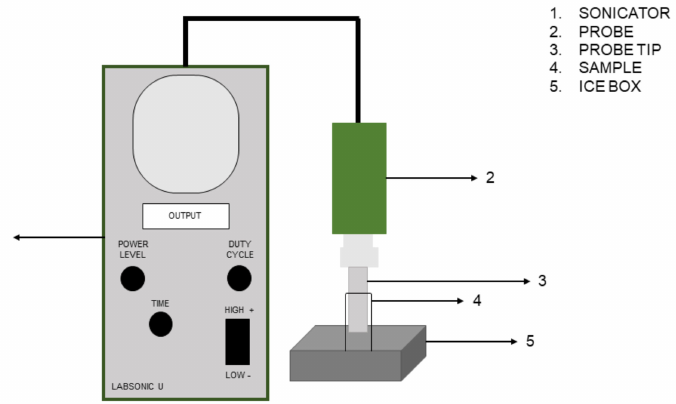
Figure 1. Schematic representation of sonicator LABSONIC U (B. Braun, Melsungen,